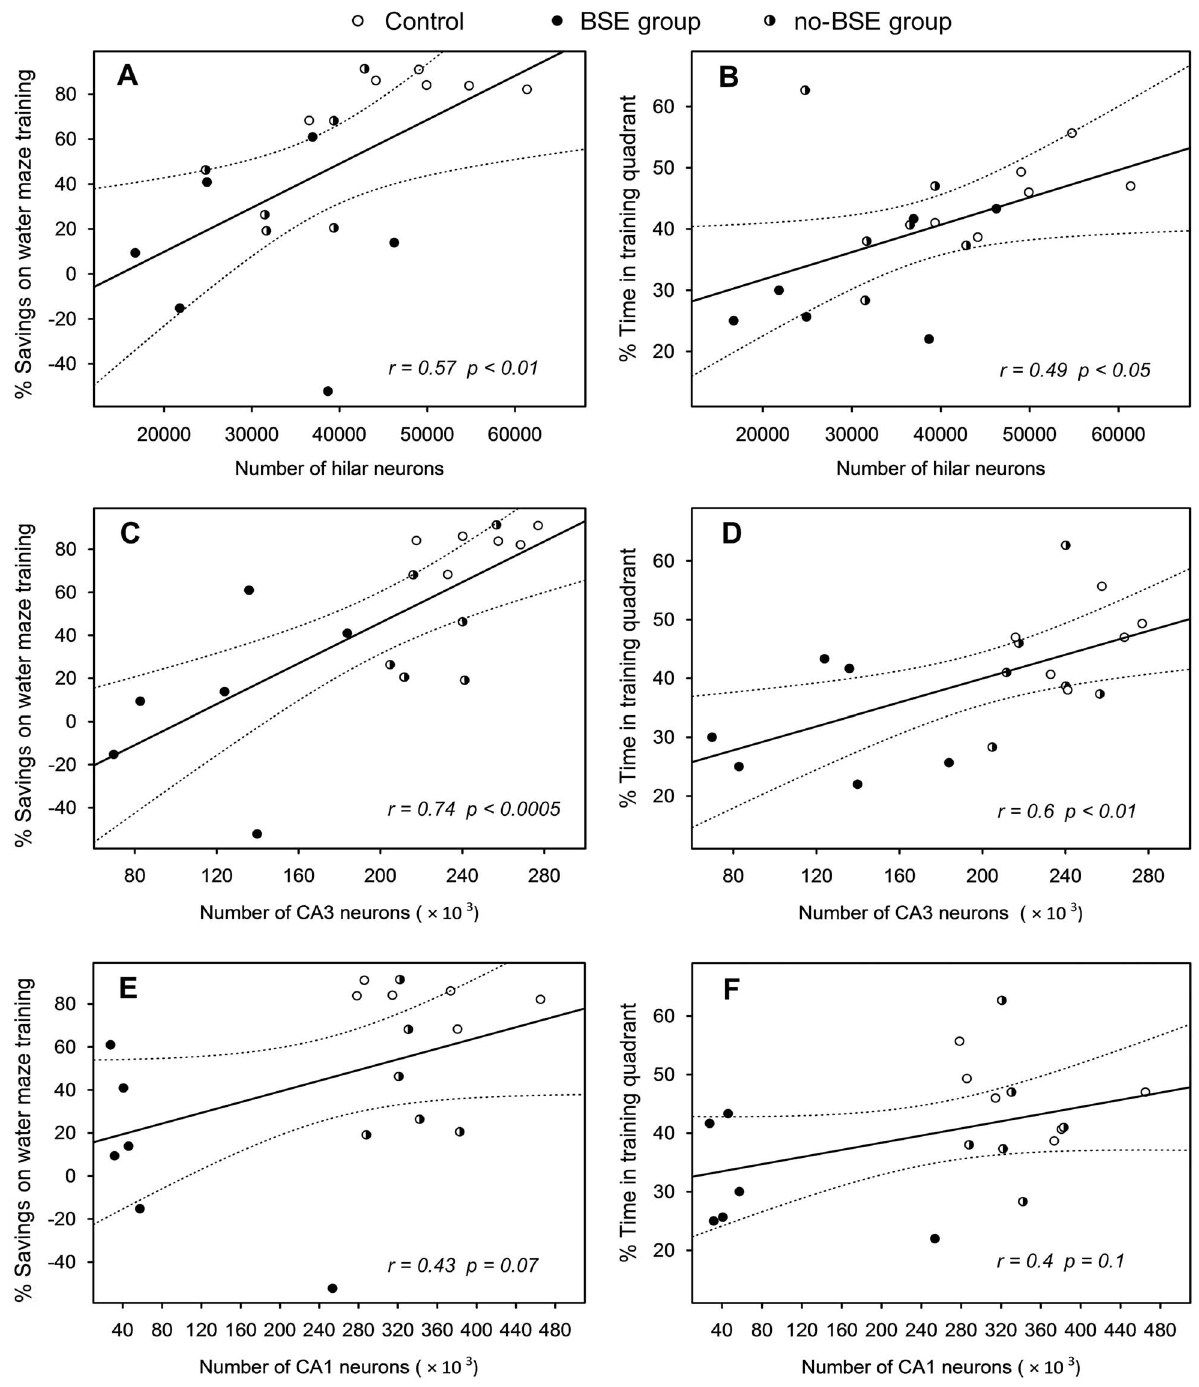
Figure 8. Correlations between hippocampal neuron numbers and spatial learning and memory indices. The x-axes represent the total numbers of neurons in the dentate hilus ( A , B ), and hippocampal CA3 ( C , D ) and CA1 ( E , F ) pyramidal fields in control and kainate-treated rats. The y- axes represent the percentages of savings during water maze training, i.e. the differences, in %, between the mean distances swum by rats on the first four trials and on the last four trials ( A , C , E ), and the percentages of time spent by rats in the training quadrant of the water maze during the probe trial ( B , D , F ). Data obtained from 6 animals randomly selected from each group (final n=18) were used in the correlational analyses. Correlation coefficients are shown at the bottom of each plot and dashed lines represent 95% confidence intervals. doi:10.1371/journal.pone.0084722.g008 effect, it has been recently shown that hippocampal volume of the volumetric estimates of the amygdala and the indices of epileptic rats significantly correlates with their learning and emotionality [9,53]. In this study, we detected marked loss of memory abilities [9,53]. Similar relationships were found between hippocampal CA3 and CA1 pyramidal neurons in rats that had